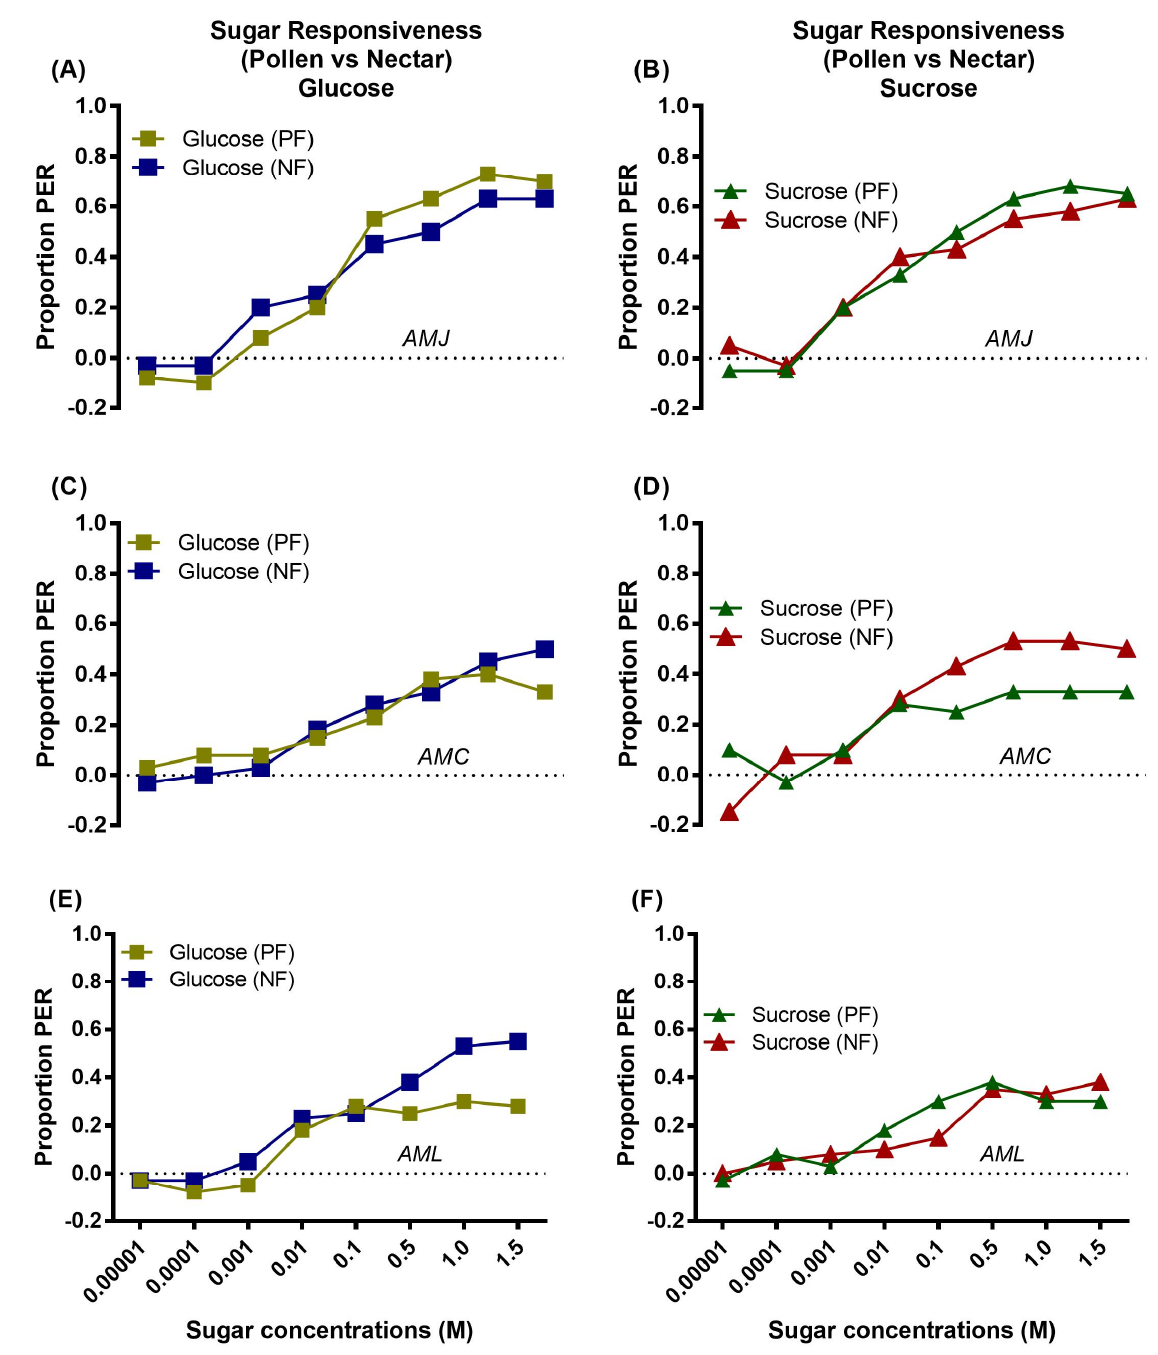
Figure 7. Comparison of sugar responsiveness to glucose and sucrose between pollen and nectar foragers of a single honey bee subspecies AMJ ( A : glucose & B : sucrose), AMC ( C : glucose & D : sucrose) and AML ( E : glucose & F : sucrose) during the fall season. In each figure, asterisks indicate the significant difference ( x 2 or Fisher’s exact test * p < 0.05 ) between the responses of pollen and nectar foragers of individual honey bee subspecies to different concentrations of glucose or sucrose.